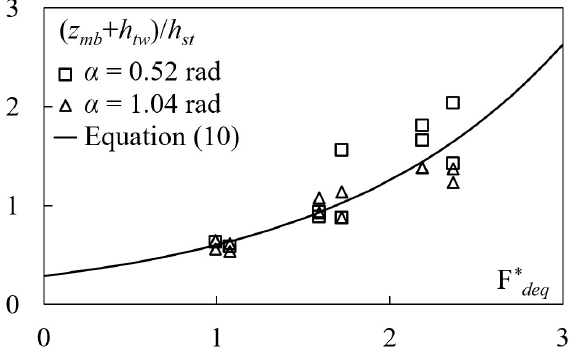
Figure 6. ( l m + h tw )/ h st vs. F* deq for wood bundles inserted in a straight channel (( B − b )/ R = 0) and the inner (( B − b )/ R = 0.213) and outer (( B − b )/ R = 0.038) banks of a curved channel, along with the plot of Equation (9).